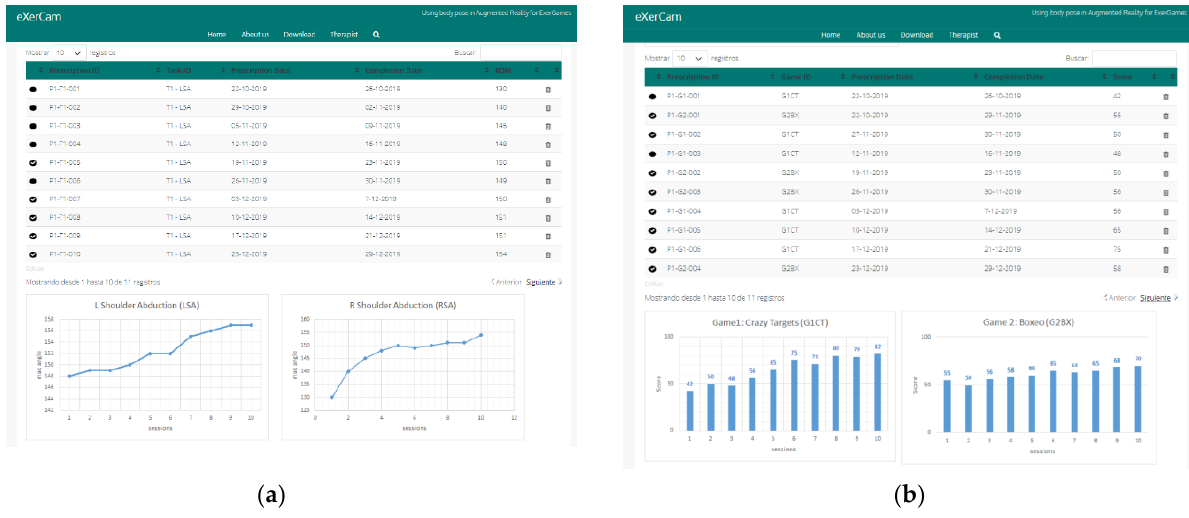
Figure 9. Result page. ( a ) Main page of Patient 1, showing the Task Results section. ( b ) Main page of Patient 1, showing the Game Results section.